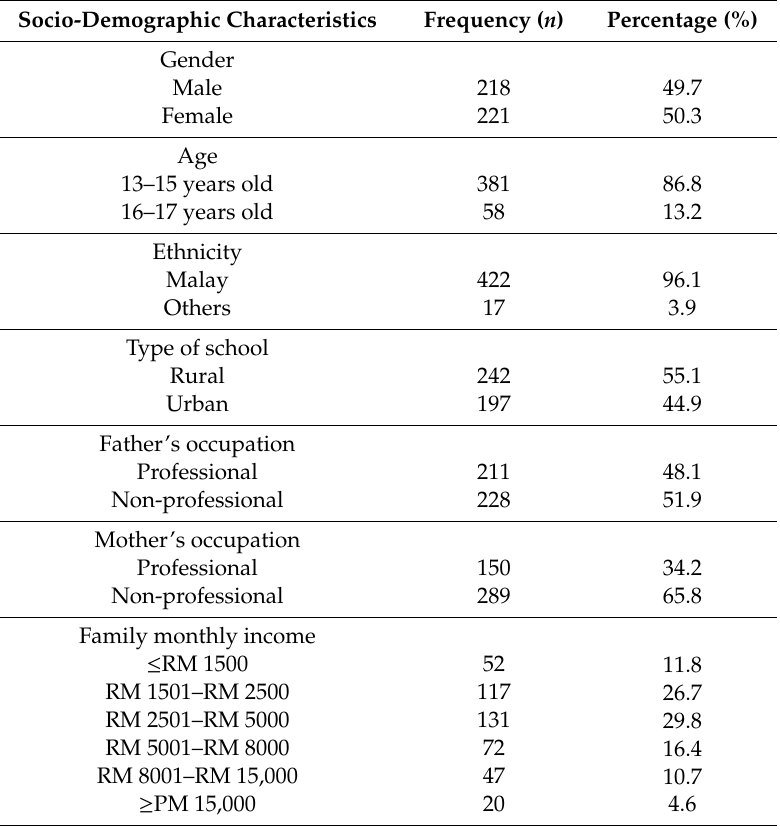
Table 1. Characteristics of respondents ( n =